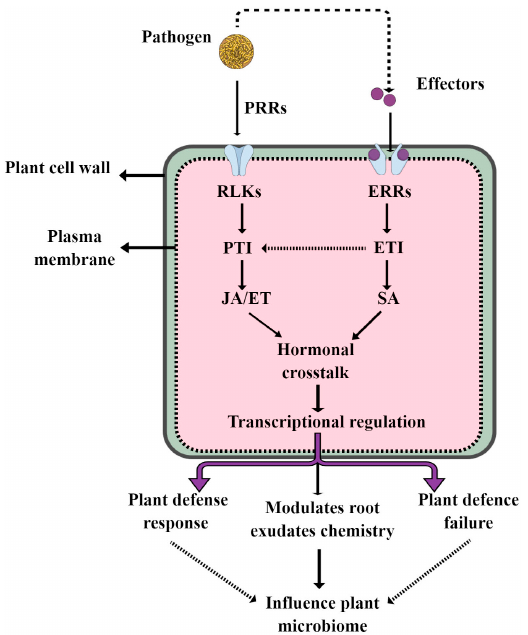
Figure 4. This model highlights how plant defense signatures such as SA, JA and ET influence the plant microbiome during pathogen interactions.